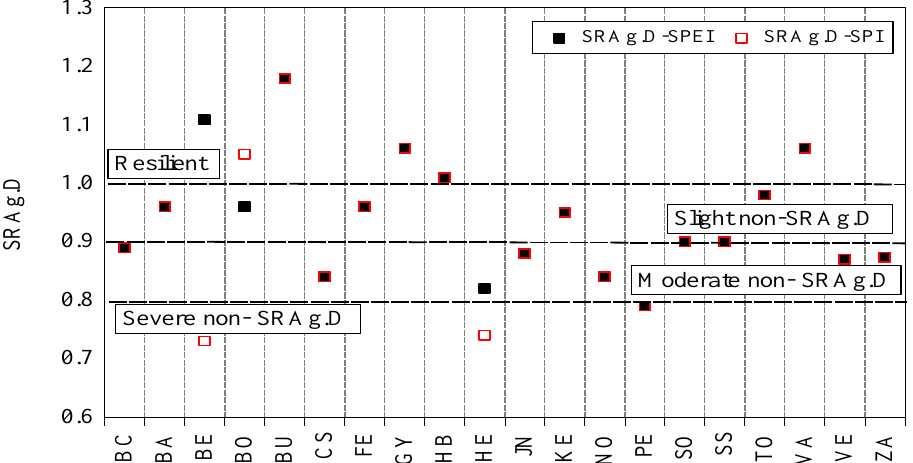
Figure 10. Resilience of sunflower production to Ag.D across Hungarian counties (2000–2010).